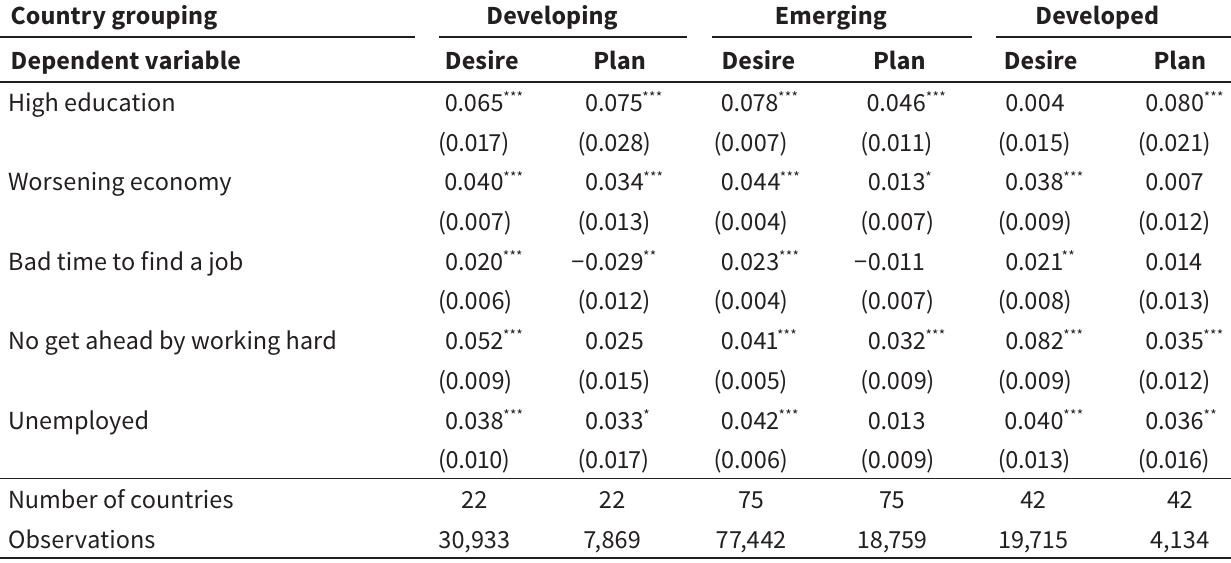
Panel B: Sample restricted to the period 2013 − 2016